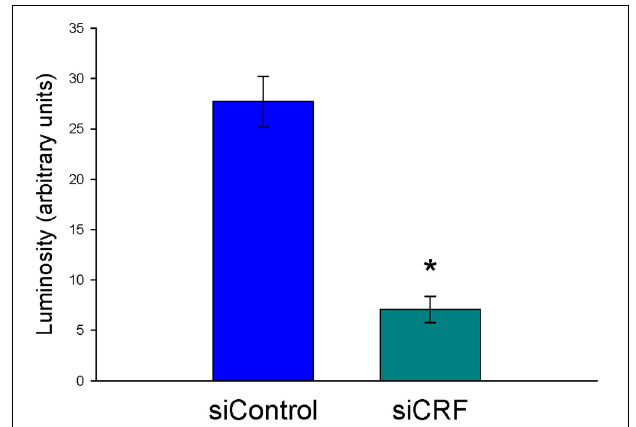
FIGURE 3 | Corrected luminosity (arbitrary units) of CRF immunofluorescence within the CeA of control (scrRNA) and siRNA